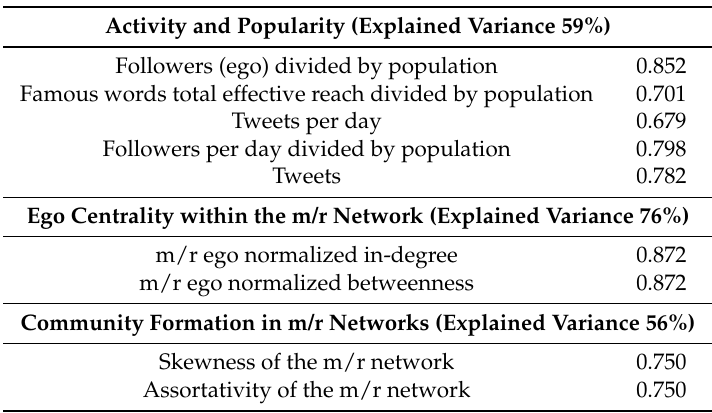
Table 1. Factor loadings of the three PCA which results to the three partial indexes.